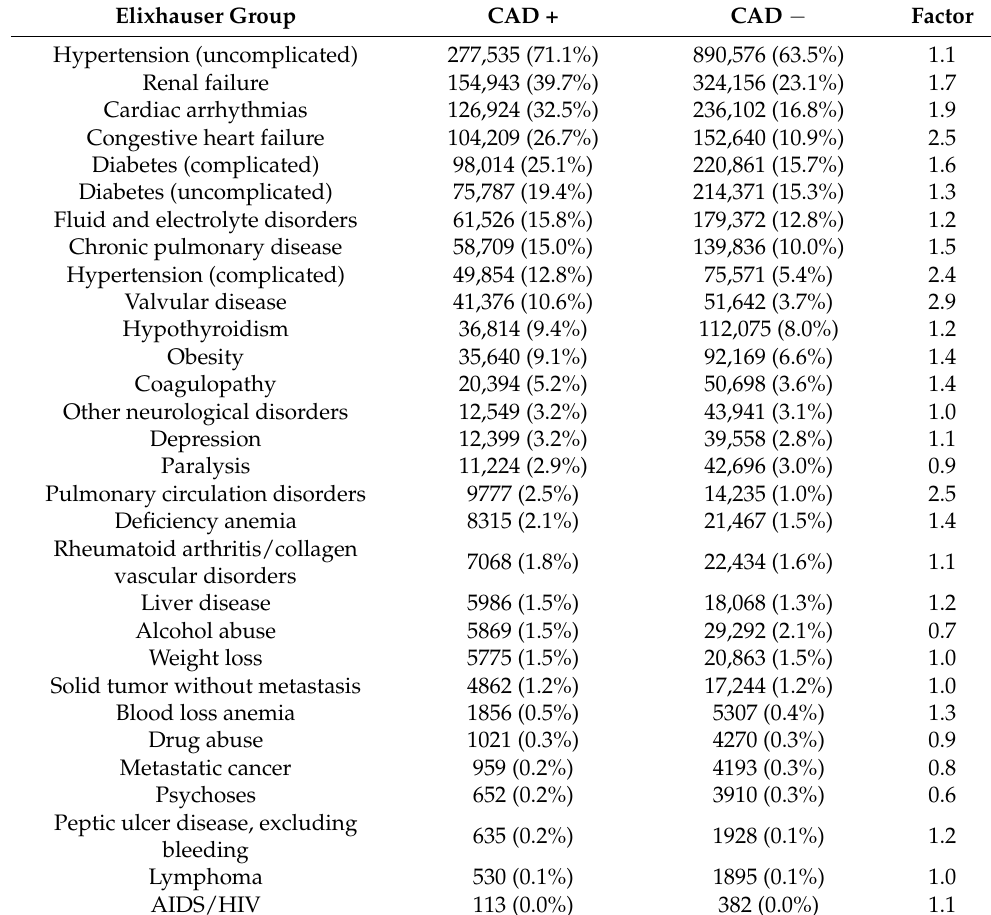
Table 3. Distribution of Elixhauser groups among patients hospitalized for peripheral artery disease with and without concomitant coronary artery disease between 2009 and